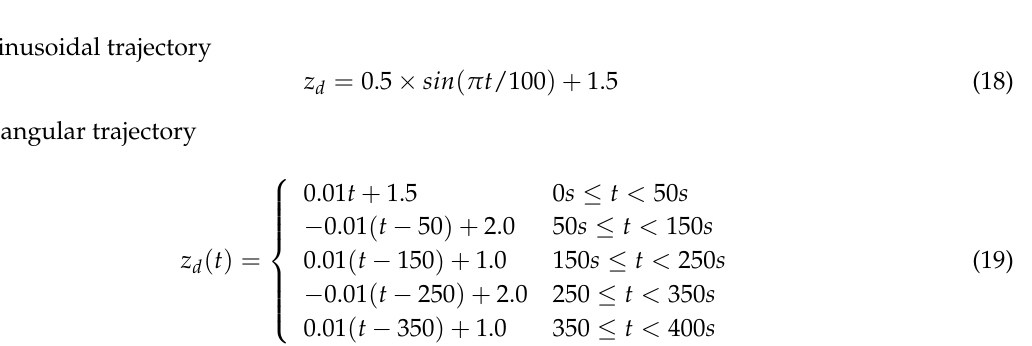
Table 2. Statistical Result of Figure 9. Figure 9. Contrast experiment result for MPC with fixed Γ u and adjusting Γ u tracking sinusoidal and triangular trajectories. ( a ) Depth data tracking sinusoidal trajectory; ( b ) error data tracking sinusoidal trajectory; ( c ) depth data tracking triangular trajectory; and, ( d ) error data tracking triangular trajectory.